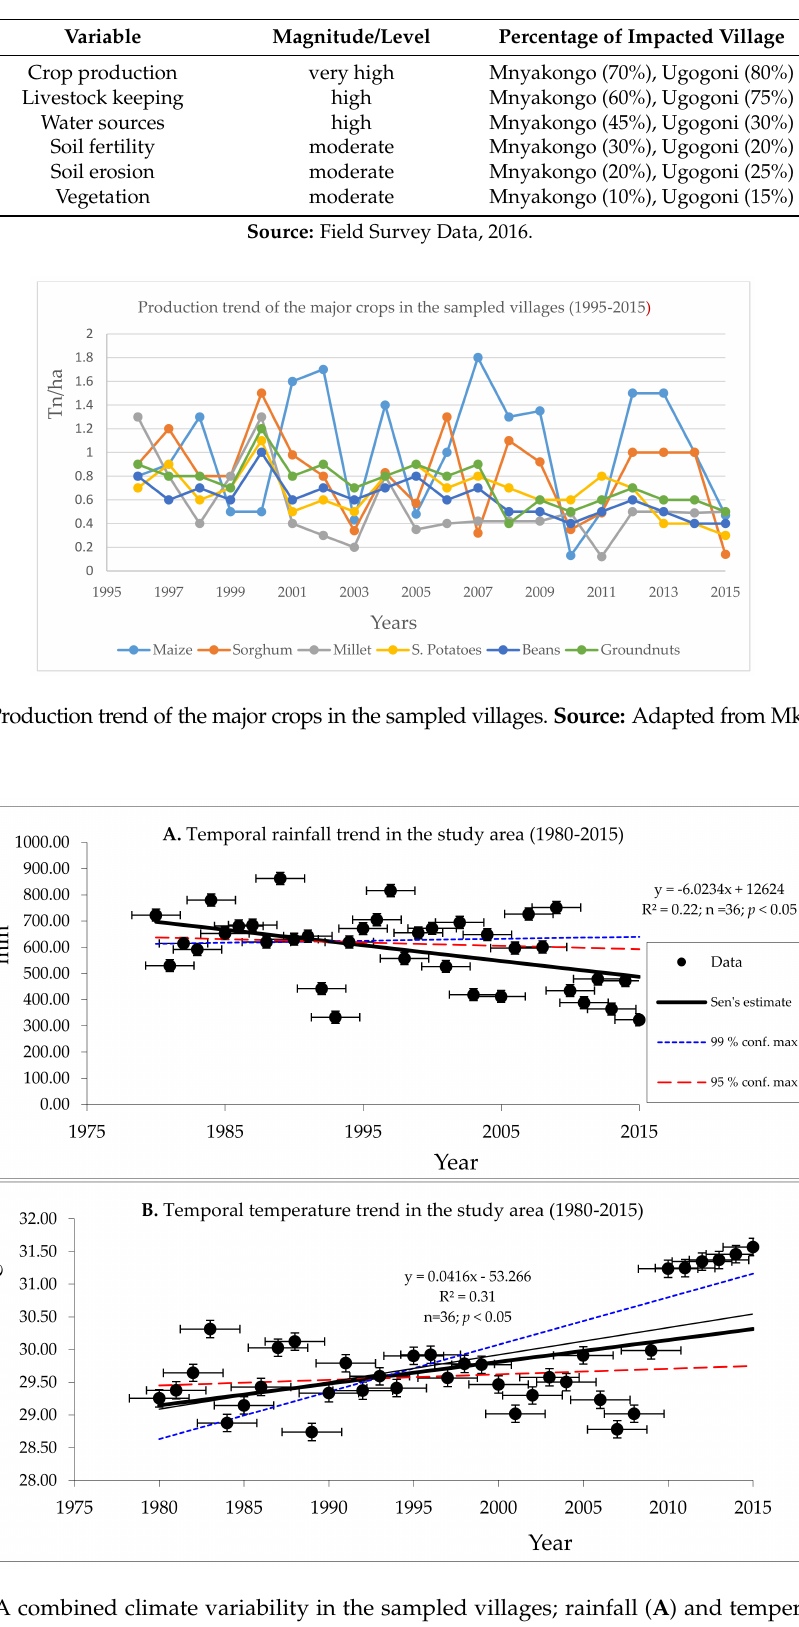
Figure 4. A combined climate variability in the sampled villages; rainfall ( A ) and temperature ( B ). The legend inserted in ( A ) equally represents ( B